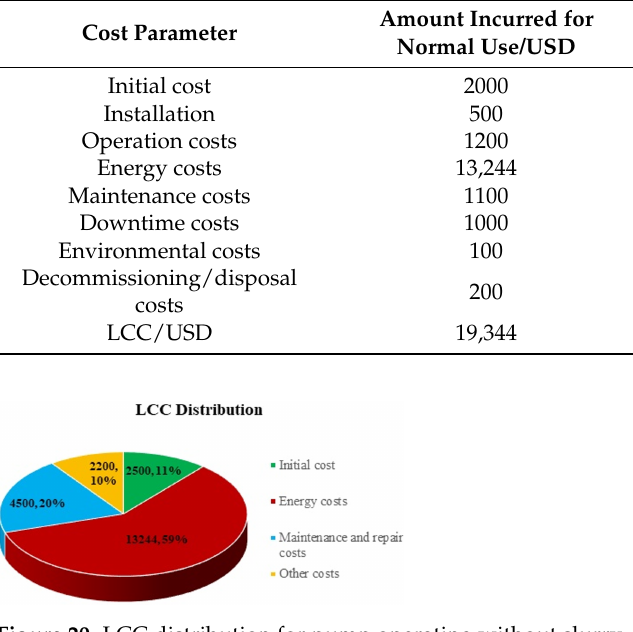
Table 6. LCC cost comparison.